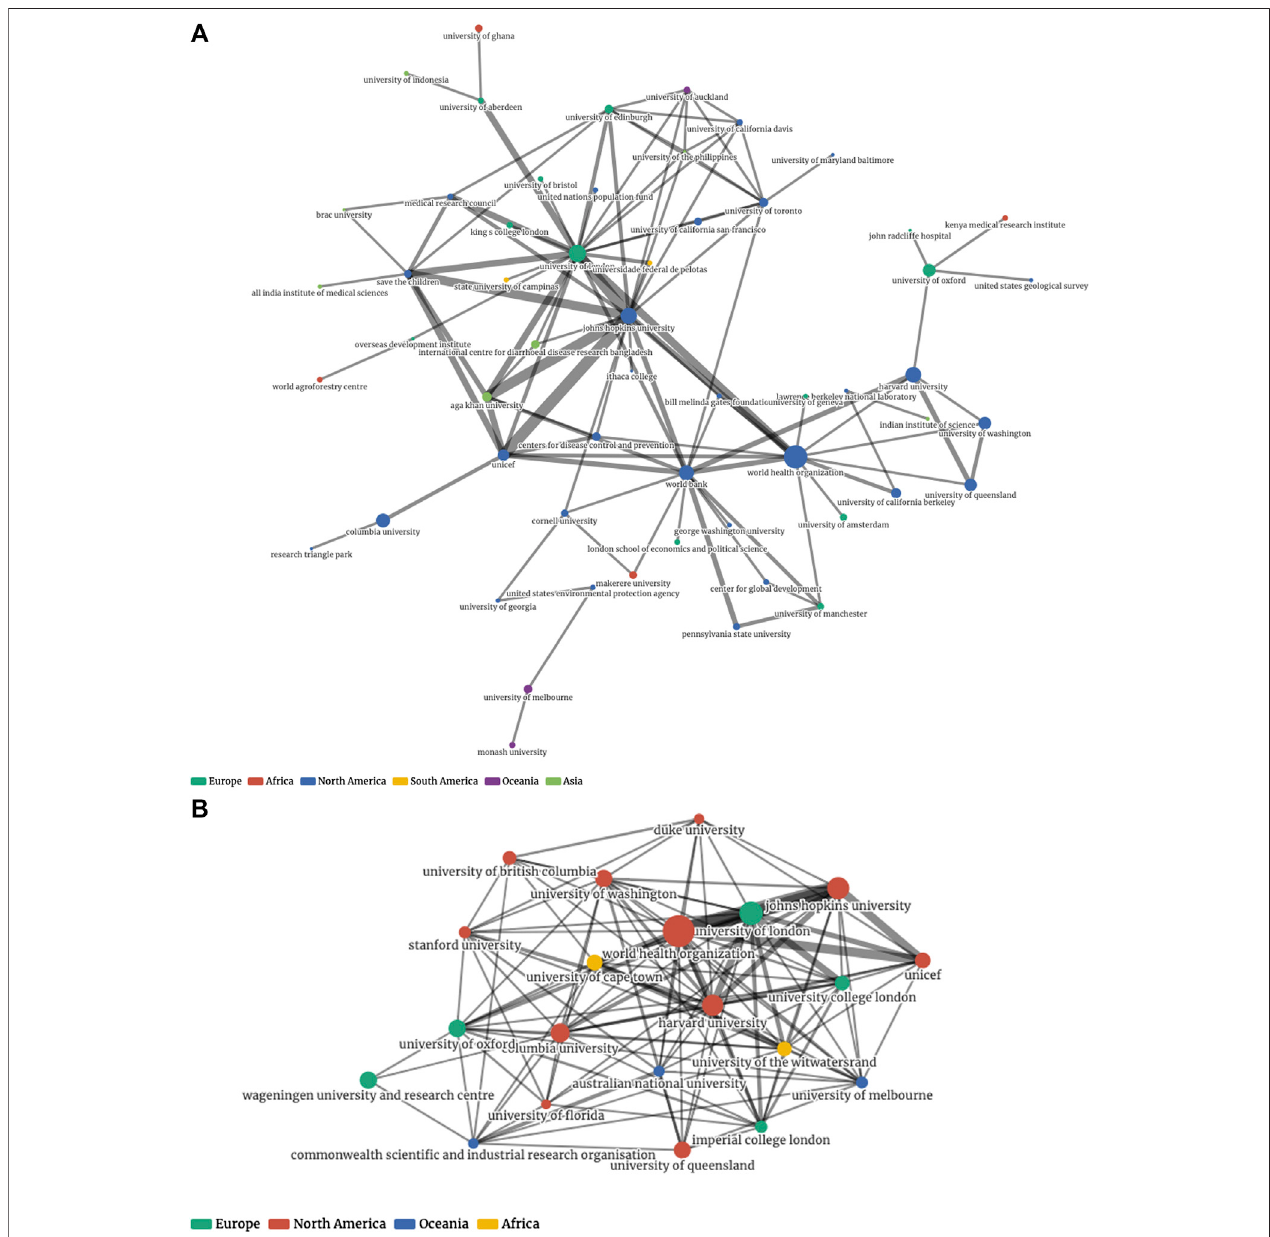
FIGURE 8 | Representations of institutional networks by time period: (A) Repeat collaboration network, 1999 – 2008. (B) Top 20 nodes by degree, 2009 –